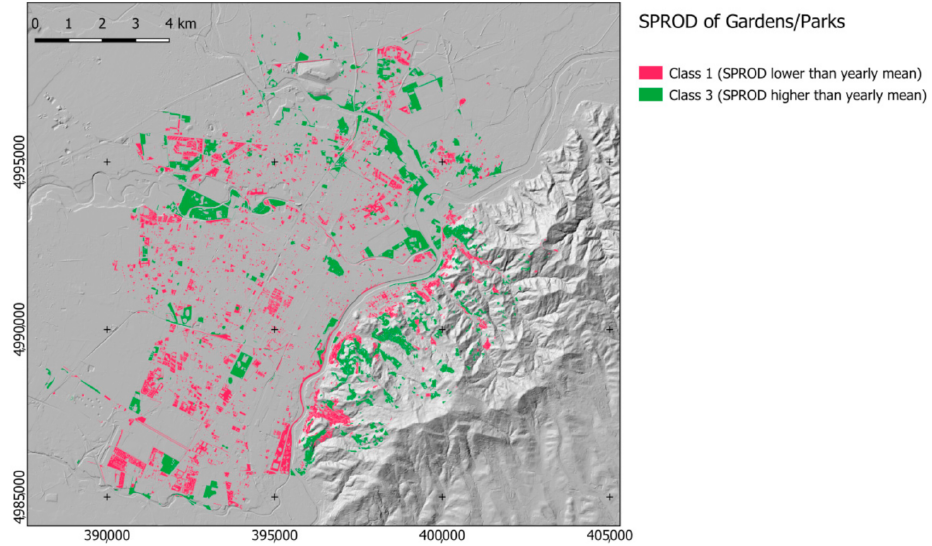
Figure 8. SPROD stable anomalies (green = positive, magenta = negative) of the sole urban green class (garden and